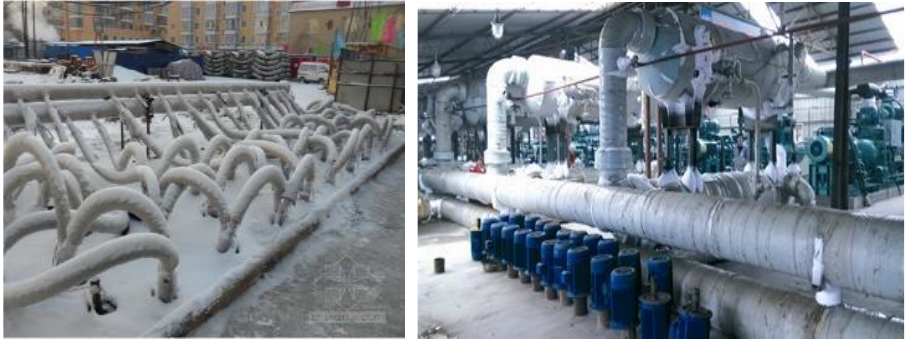
Figure 22. Artificial freezing method application